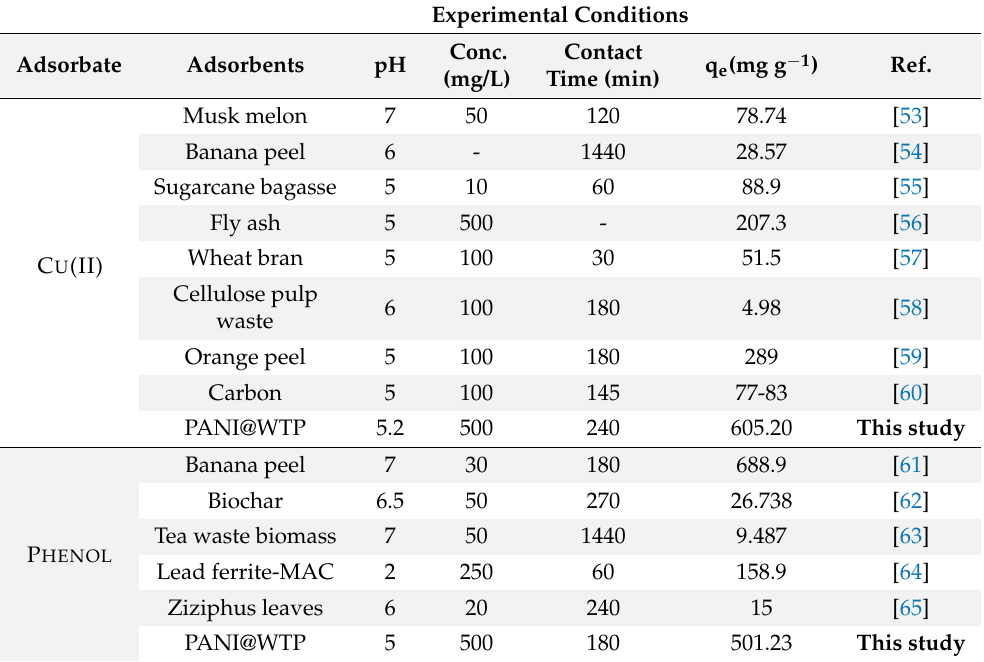
Table 3. Comparison of maximum adsorption capacity of Cu(II) and phenol with other materials.